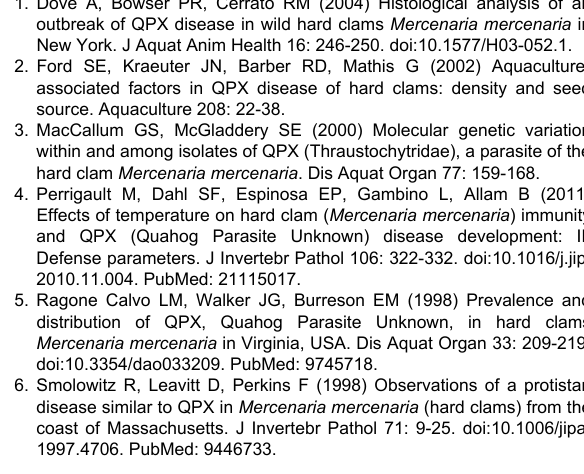
Table S5. Relative gene expression values (RPKM: reads per exon model per million mapped reads) between